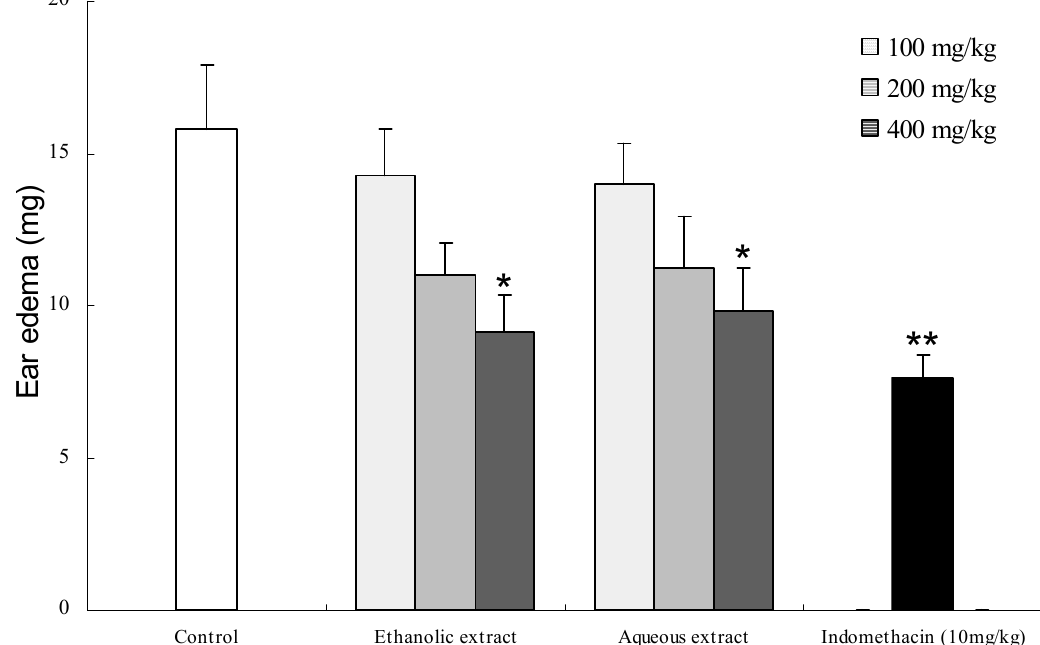
Values of edema shown are mean ± S.E.M. ( n = 6). * p < 0.05; ** p < 0.01 vs . control